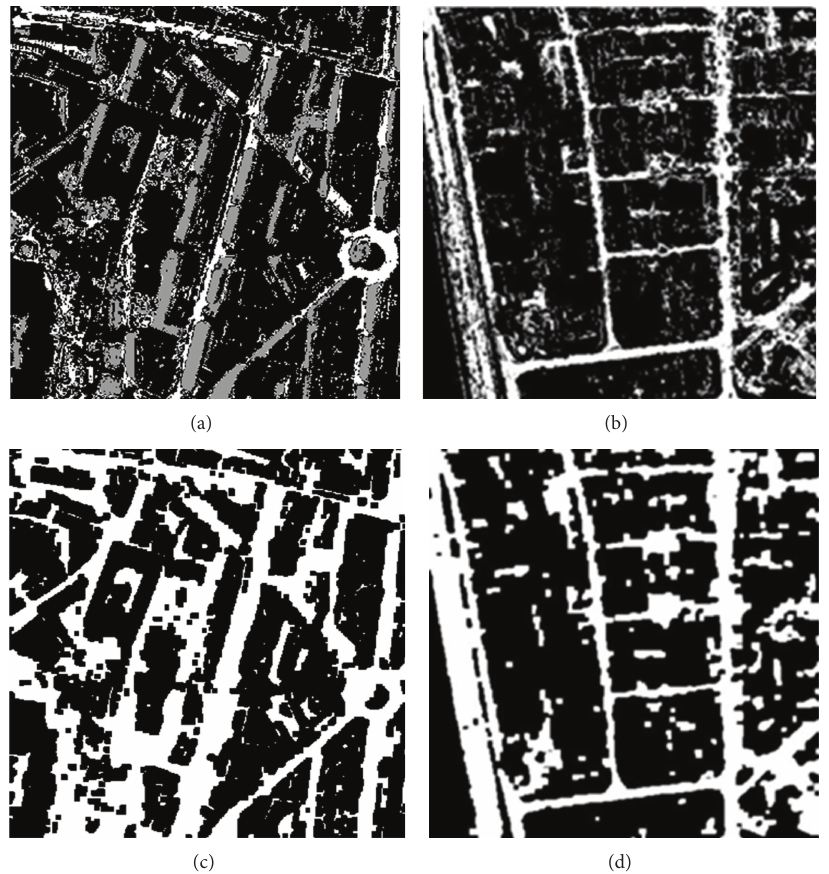
Figure 4: Road networks ((a) and (b)) extracted from classified images and ((c) and (d)) fixed by the morphological